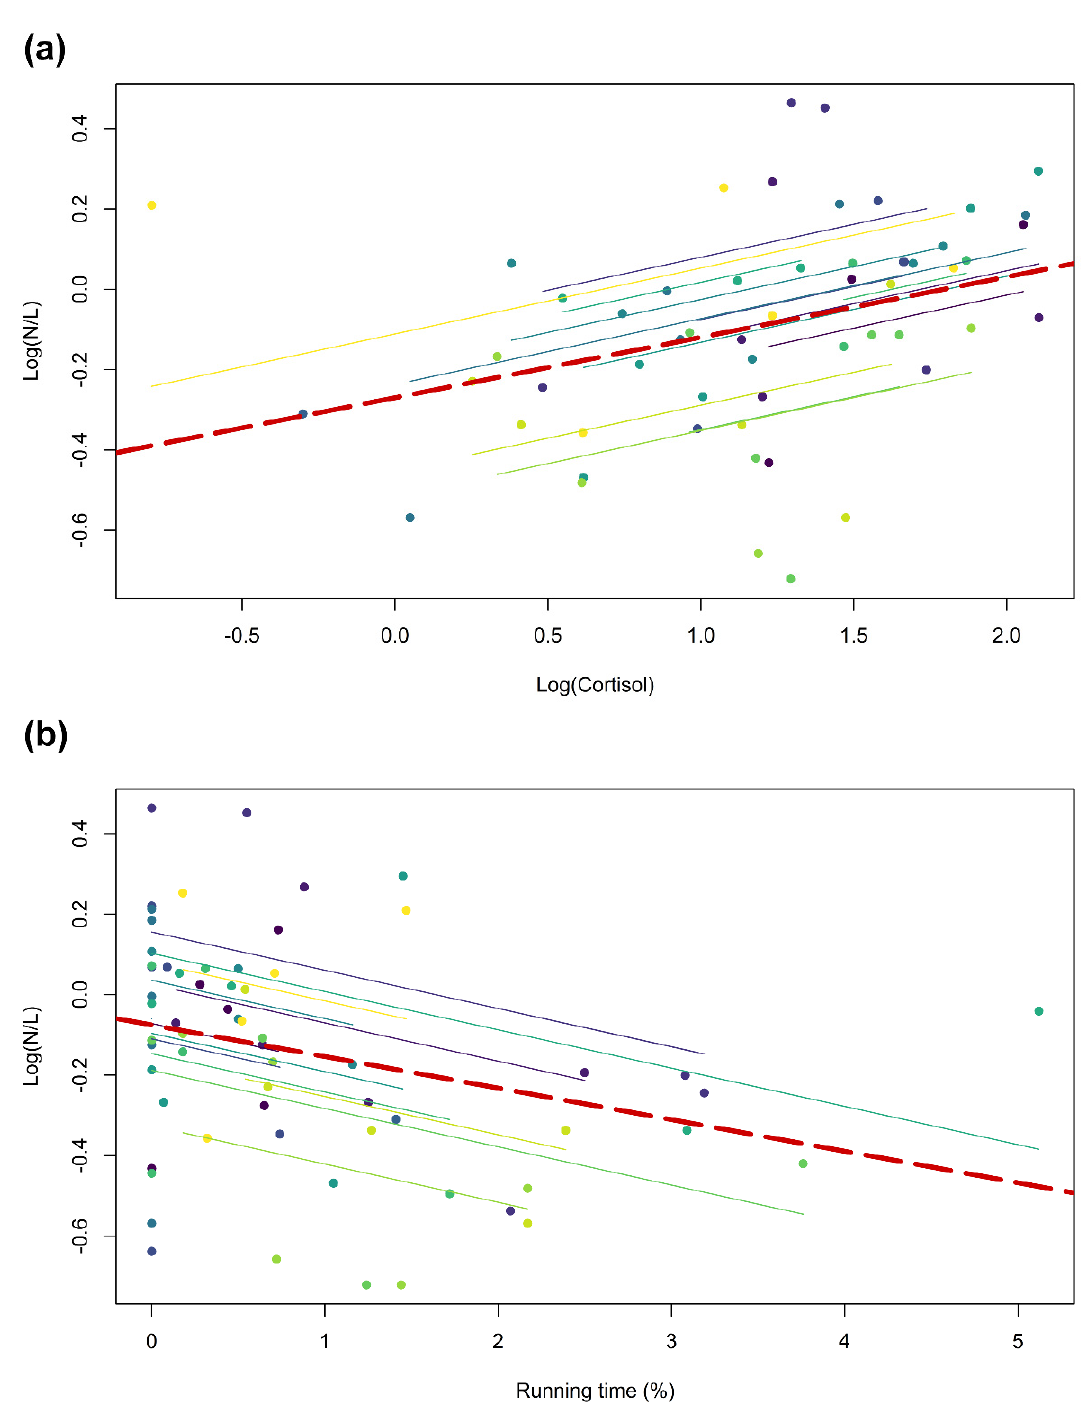
Figure 1. ( a ) Significant correlation between neutrophil-to-lymphocyte ratio (N/L) and cortisol (r rm = 0.381; 95% CI = 0.083, 0.617; p = 0.012). ( b ) Significant correlation between N/L and relative duration of running (r rm = − 0.351; 95% CI = − 0.575, − 0.077; p = 0.015). Values for N/L and cortisol are log10 transformed. Data are based on 21 dairy calves observed every week from the 3rd to 31st day of age at CiRAA (Centro di Ricerche Agro-Ambientali “E. Avanzi”—University of Pisa). Different colors indicate different individuals, dashed red lines indicate the overall